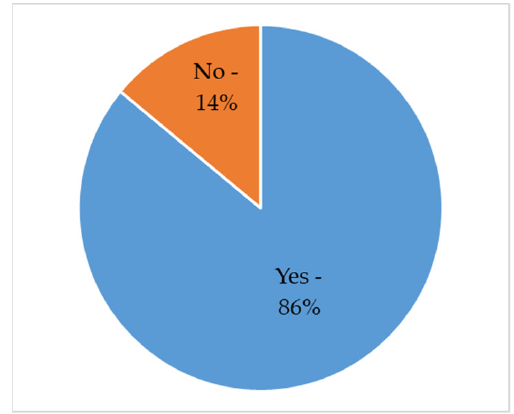
Figure 9. Selected survey results—an analytical–economic perspective: can the current energy system, in the province you represent, be considered effective as far as your area is concerned?